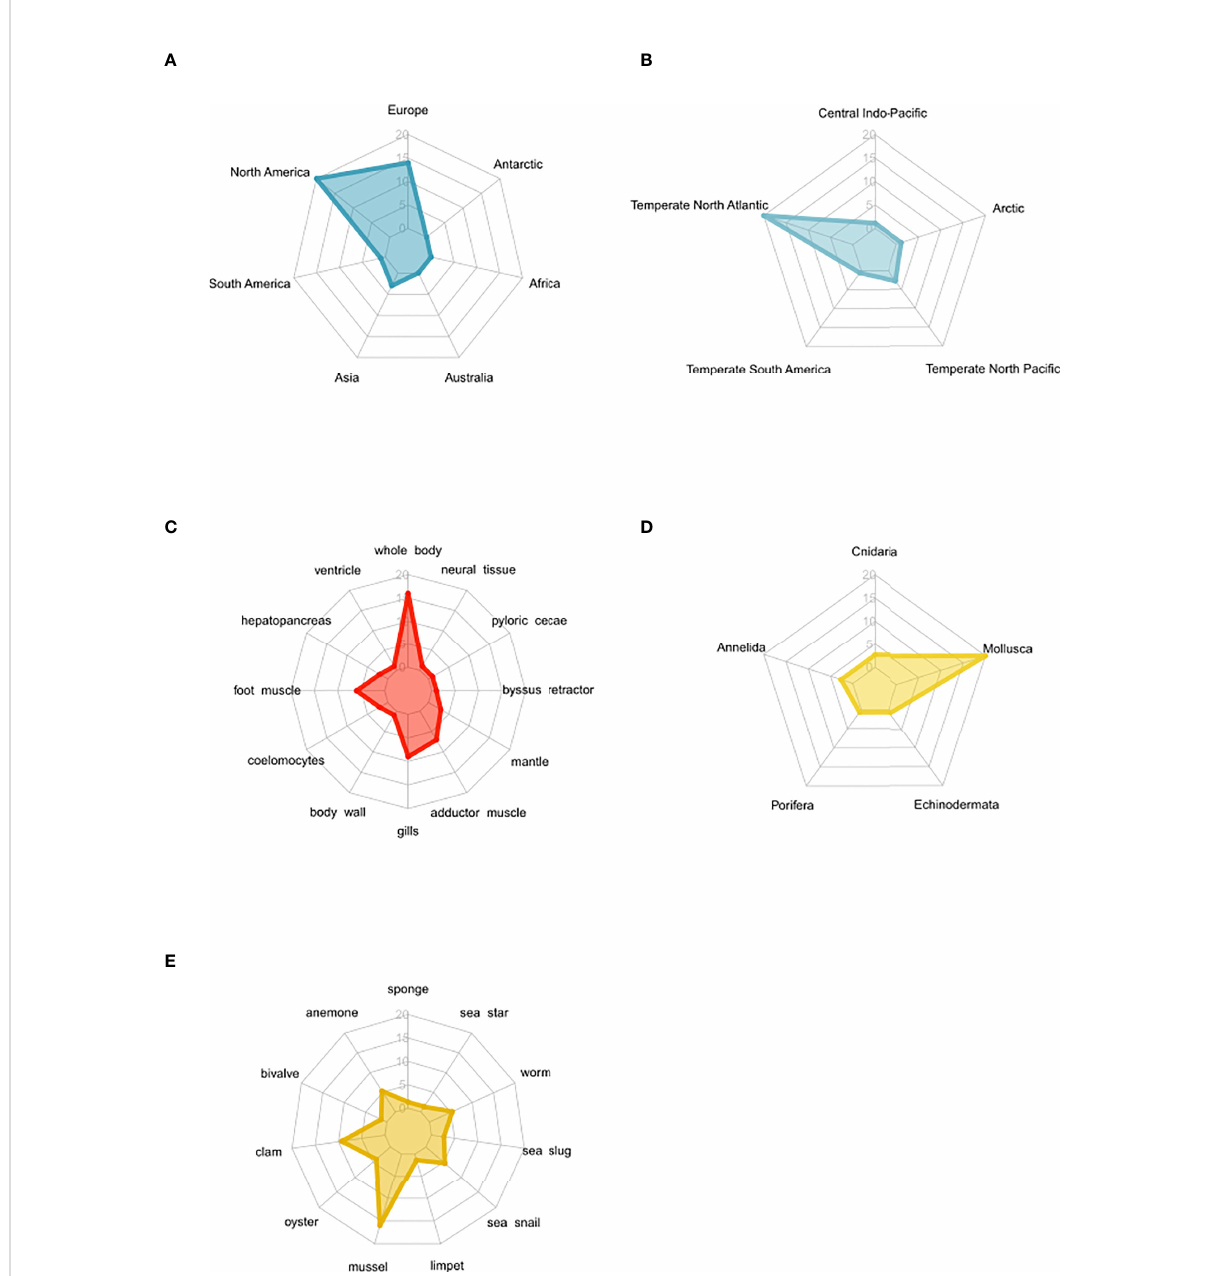
FIGURE 3 Spider plots highlighting the distribution of studies that measured osmolyte concentrations in osmoconformers following long-term acclimation to low salinity regimes. The number of studies increases from the center (n = 0) to the margin (n = 20). (A) Spread and geographic bias of osmolyte studies. (B) Spread and publication bias of osmolyte studies by biogeographic realms. (C) Spread and bias of osmolyte studies in different tissues. (D) Phylogenetic distribution of study organisms according to taxa. (E) Phylogenetic distribution of study organisms according to common name of